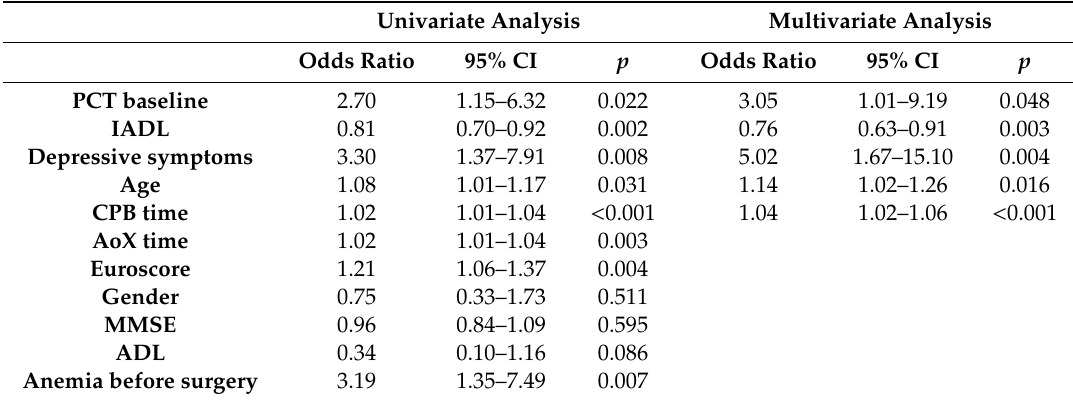
Table 4. Univariate and multivariate logistic regression analysis of the predictors of delirium. Univariate Analysis Multivariate